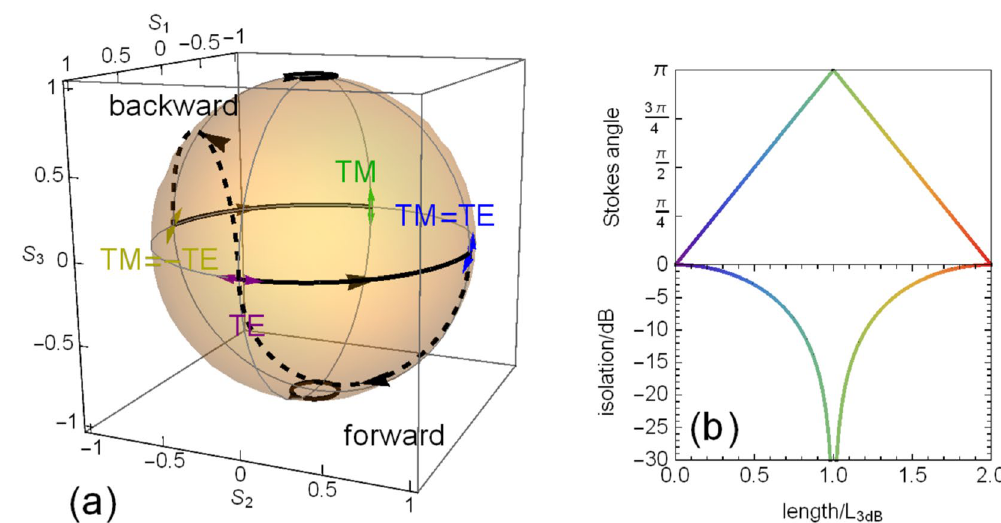
Figure 3. Operating principles of Faraday Rotation isolators. ( a ) Poincare sphere illustrating the polarization state evolution for the isolator device of Fig. 1a, where the solid lines correspond to nonreciprocal Faraday Rotation and the dashed lines to the half reciprocal phase conversion. ( b ) Relative Stokes vector angle and resulting isolation ratio obtainable vs element length, scaled to the length corresponding to 50% power transfer between modes, L 3dB . The maximum degree of isolation corresponds to orthogonal Stokes vectors, or a relative angle of π